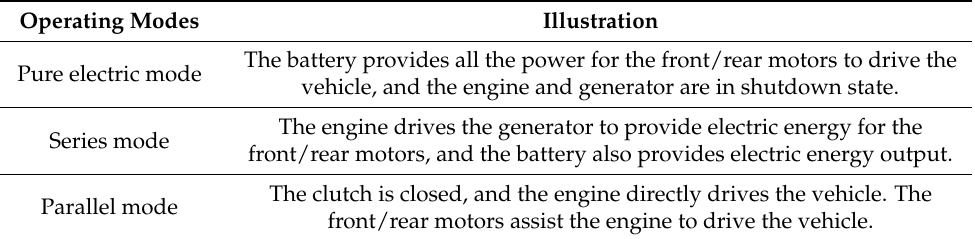
Table 2. Vehicle and dynamic components parameters in the 4DW